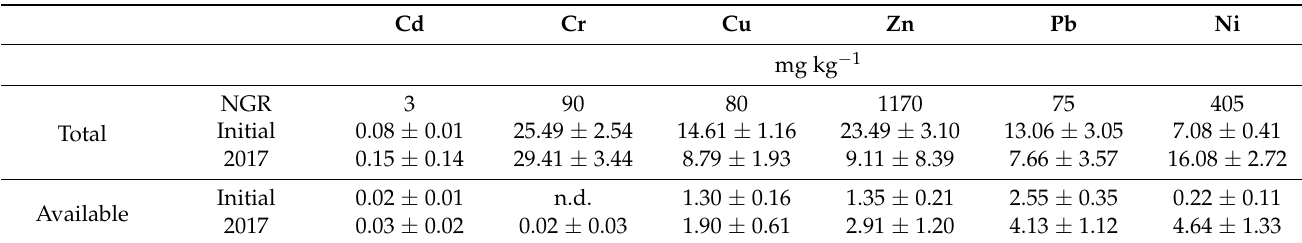
Table 4. Total and available heavy metal content (mg kg − 1 ) for the beginning of the experiment (2008), in 2017 and the generic reference values (total content) for Madrid (NGR) classified for “other uses”, mean ± sd dev ( n = 20). “n.d.” denoted “not